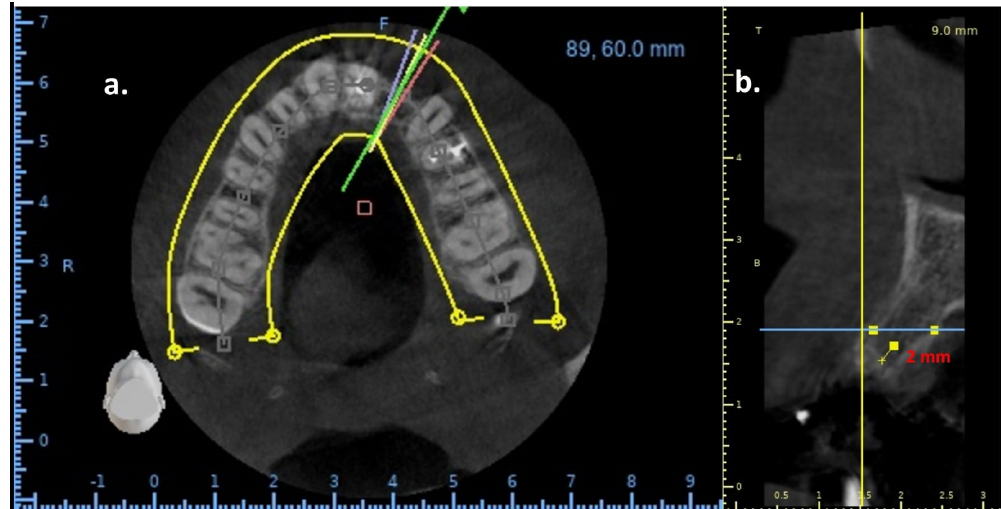
Figure 2. ( a ) Tracing the dental arch. HU measurement areas (square yellow dots); ( b ) Buccal/palatal, lingual cortical bone, and at 2 mm from the alveolar crest in the trabecular bone.